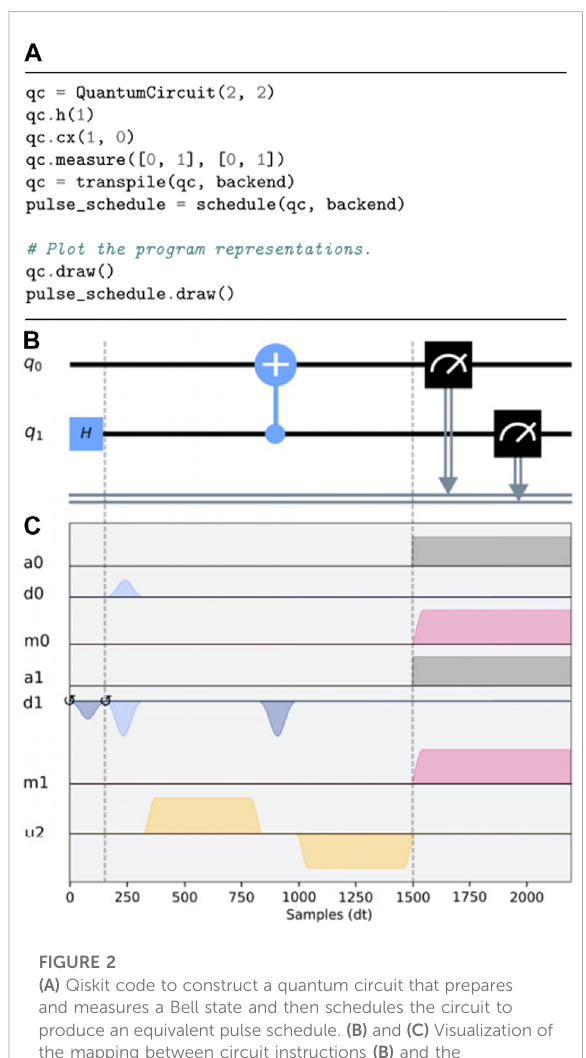
FIGURE 2 (A) Qiskit code to construct a quantum circuit that prepares and measures a Bell state and then schedules the circuit to produce an equivalent pulse schedule. (B) and (C) Visualization of the mapping between circuit instructions (B) and the composite pulse sequences that will implement the circuit elements (C) .